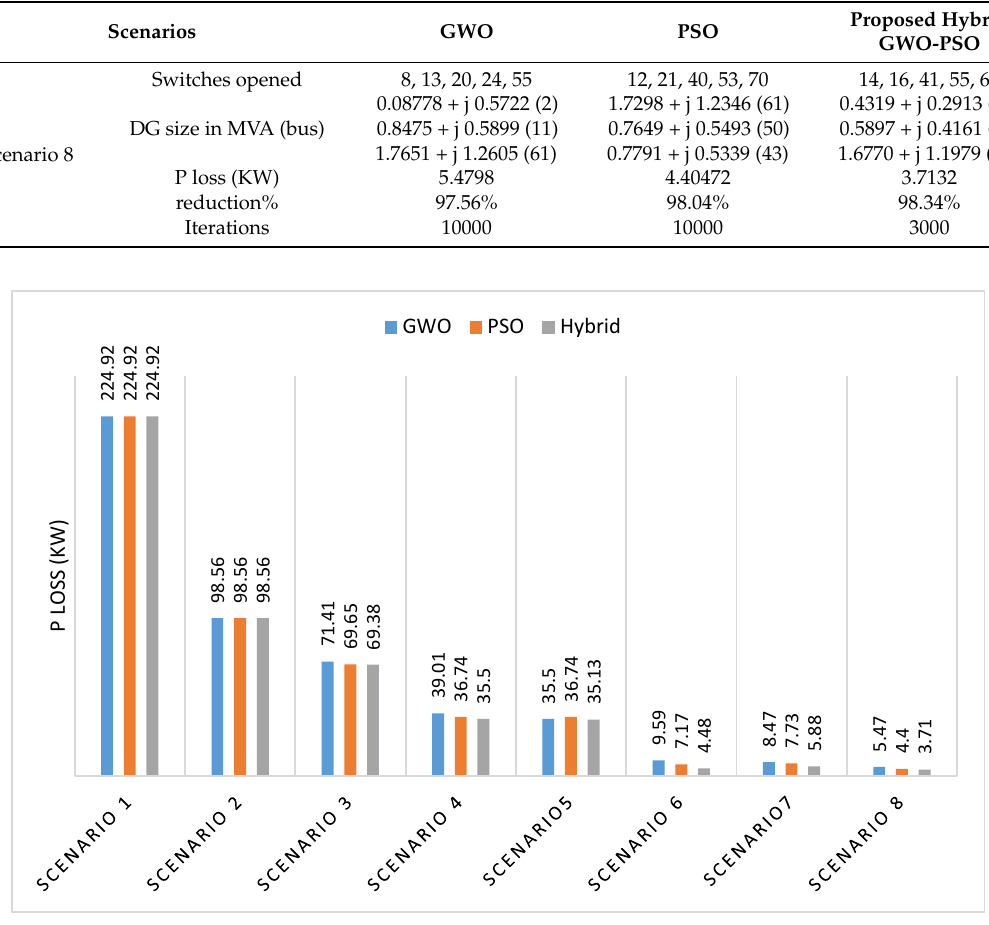
Figure 9. Power loss of the 69-bus system using three different techniques.